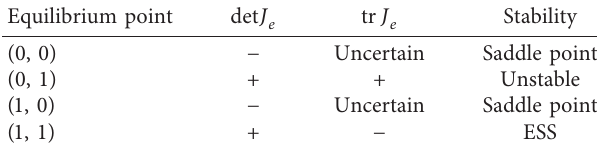
Table 7: Analysis of partial equilibrium table. Equilibrium point